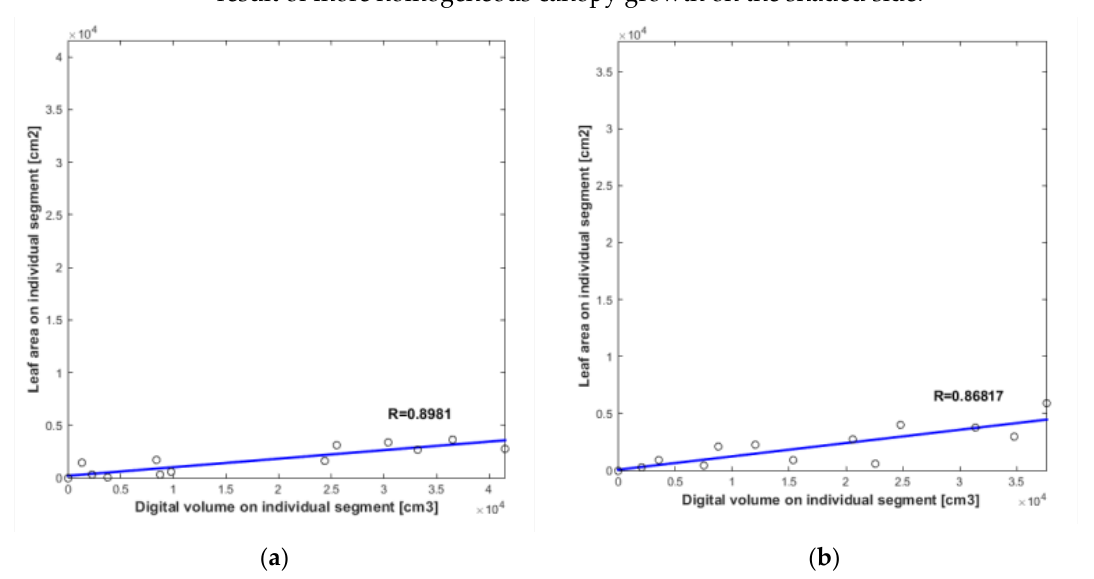
Figure 14. Correlation between vine canopy volume (lidar measurements) and leaf area (manual measurements): ( a ) left side of vine canopy and ( b ) right side of vine canopy. Correlation was performed for all 12 segments.